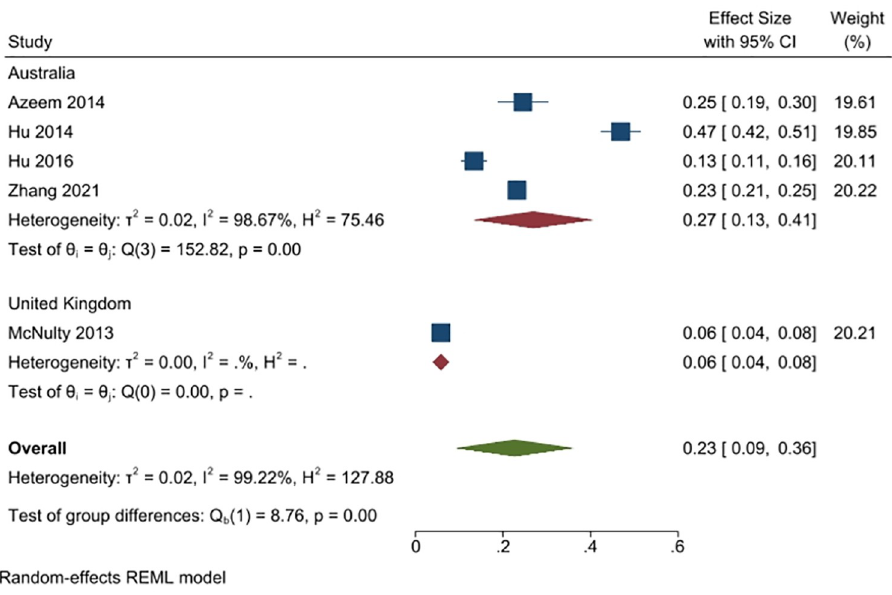
Fig 5. Percentage of respondents answering yes to the question of whether they retained leftover antibiotics.